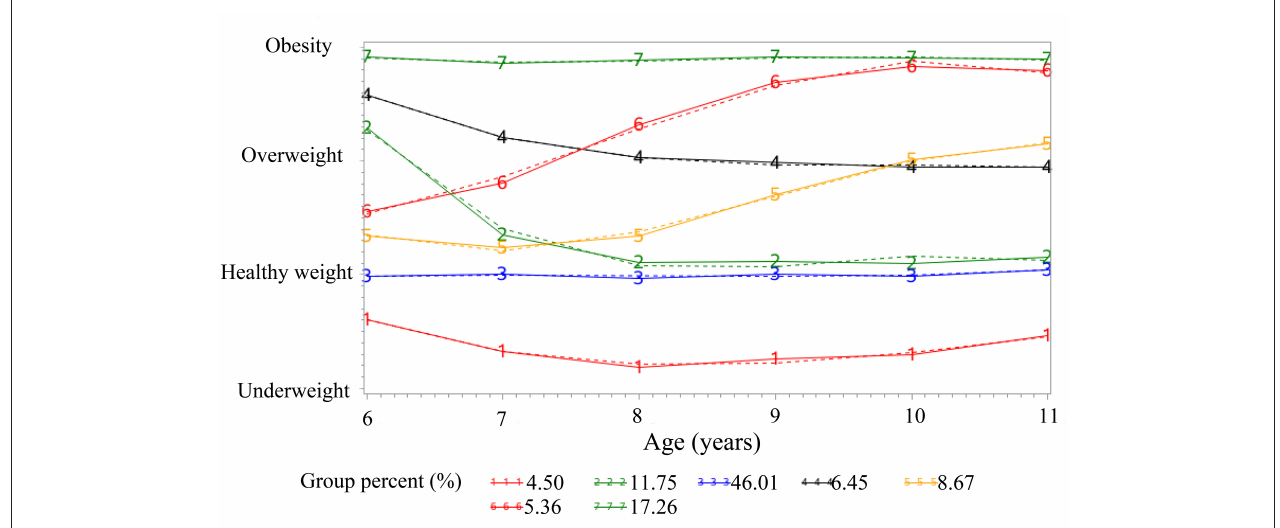
TABLE 1 | Participant disparities by sex and urban-rural region for each of the seven different BMI trajectory groups. Trajectories Total Sex Region Girls Boys Urban Rural Sustained underweight (Trajectory 1) 723 (4.50%) 368 (4.77%) 355 (4.25%) 398 (4.54%) 325 (4.45) Obesity to healthy weight (Trajectory 2) 1,887 (11.75%) 1,069 (13.86%) 818 (9.80%) 1,082 (12.35%) 805 (11.03%) Sustained healthy weight (Trajectory 3) 7,389 (46.01%) 3,954 (51.26%) 3,607 (49.40%) 1,036 (6.45%) 361 (4.94%) Healthy weight to overweight (Trajectory 5) 1,392 (8.67%) 649 (8.89%) Healthy weight to obesity (Trajectory 6) 861 (5.36%) 321 (4.16%) 540 (6.47%) 416 (4.75%) 445 (6.10%) Sustained obesity (Trajectory 7) 2,772 (17.26) 1,049 (13.60%) 1,723 (20.64%) 1,663 (18.99%) 1,109